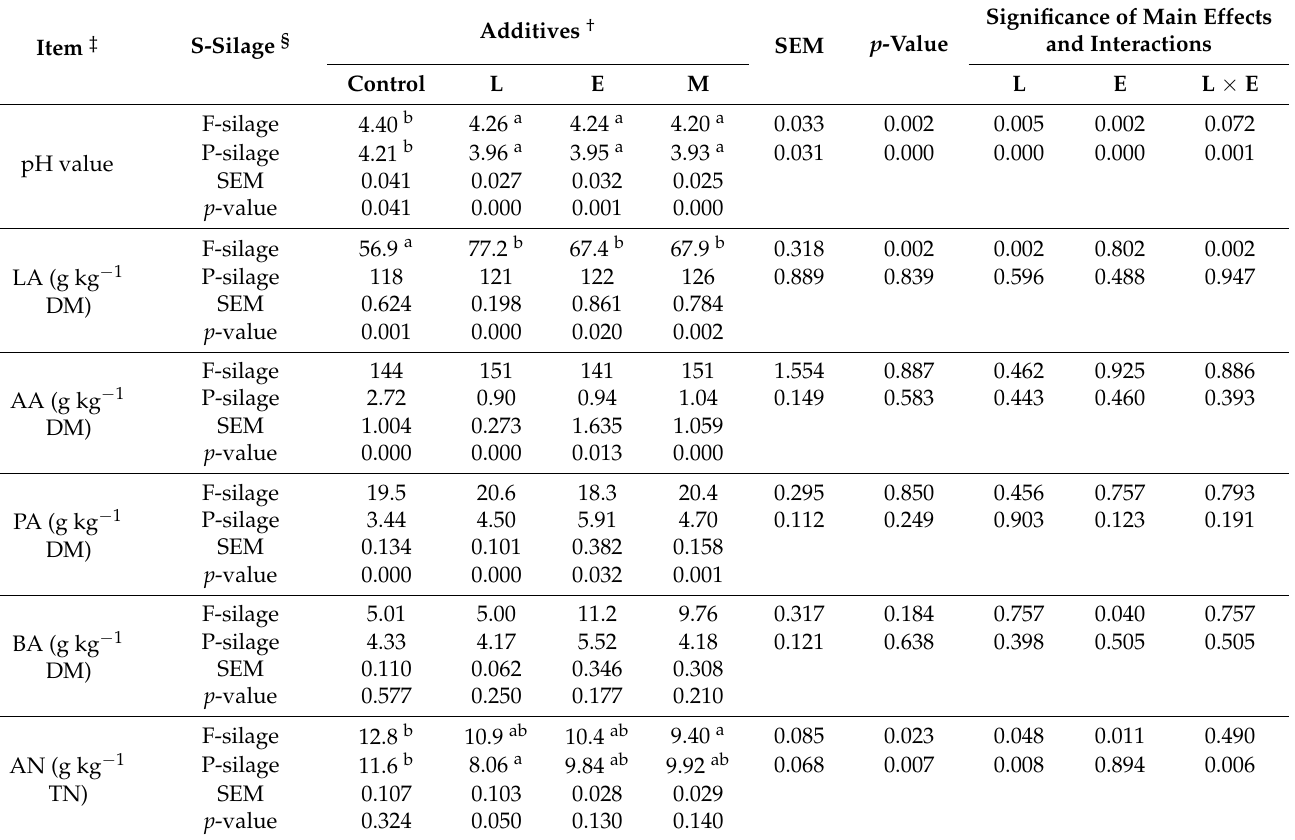
Table 3. Fermentation quality of spent mushroom substrate silages prepared with lactic acid bacteria and cellulase.